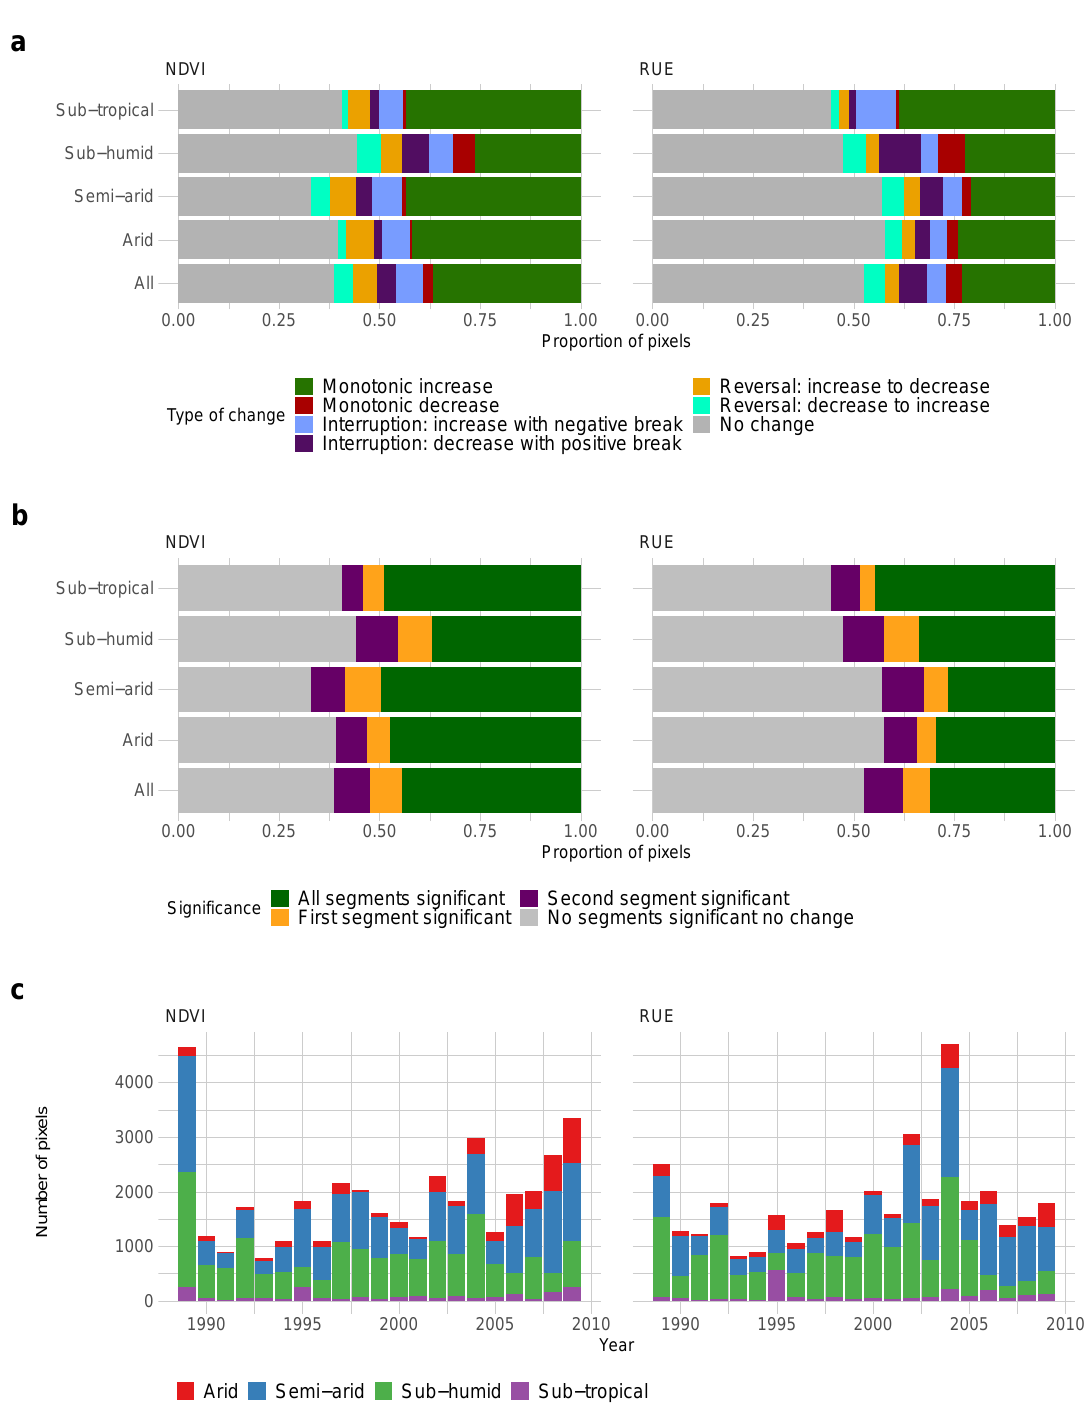
Figure 4. Trend breaks stratified by agro-ecological zone: ( a ) trend type, ( b ) trend significance; ( c ) year of